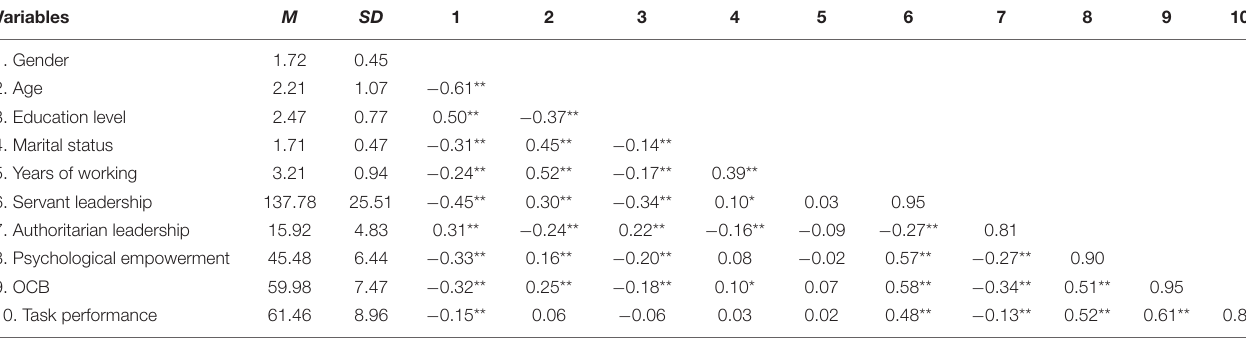
TABLE 4 | Means, standard deviations, and correlations ( N = 315). Variables